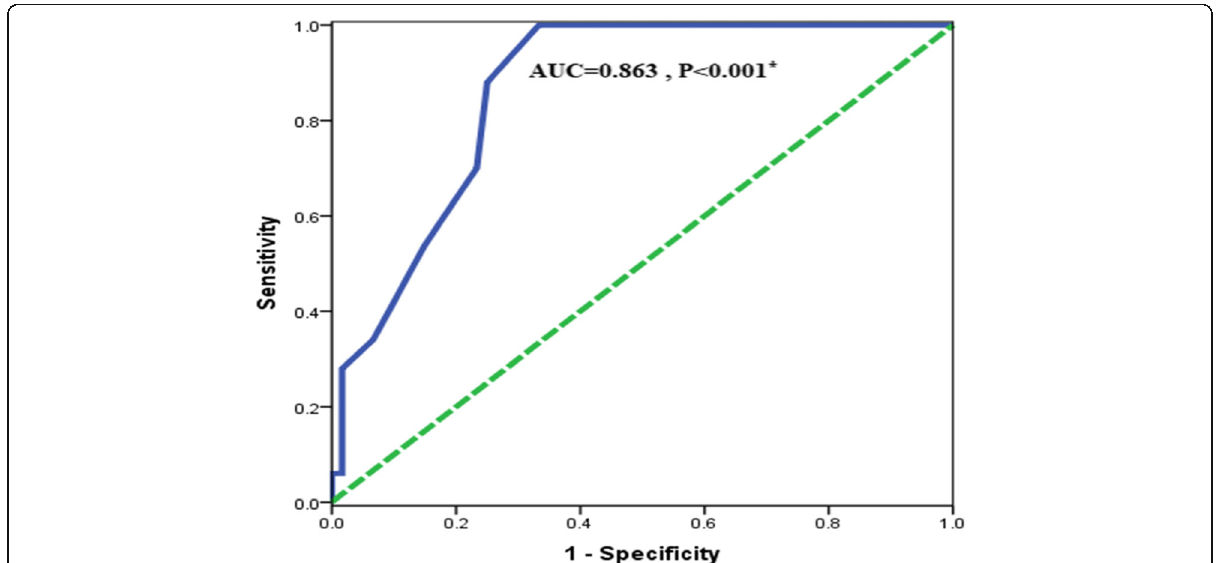
Fig. 4 Receiver operating characteristic (ROC) curve for on plasma ghrelin (ng/ml) as diagnostic biomarkers for diagnosis of PCOS group among obese